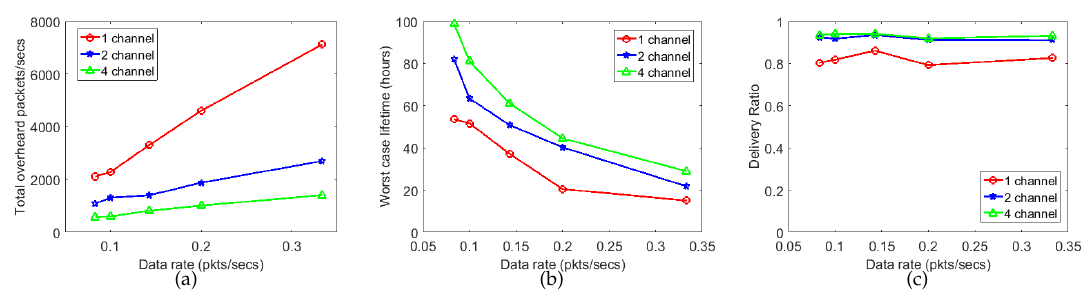
Figure 11. Comparison of ( a ) network-wide packets overheard; ( b ) worst case network lifetime and ( c ) packet delivery ratio with different data rates.